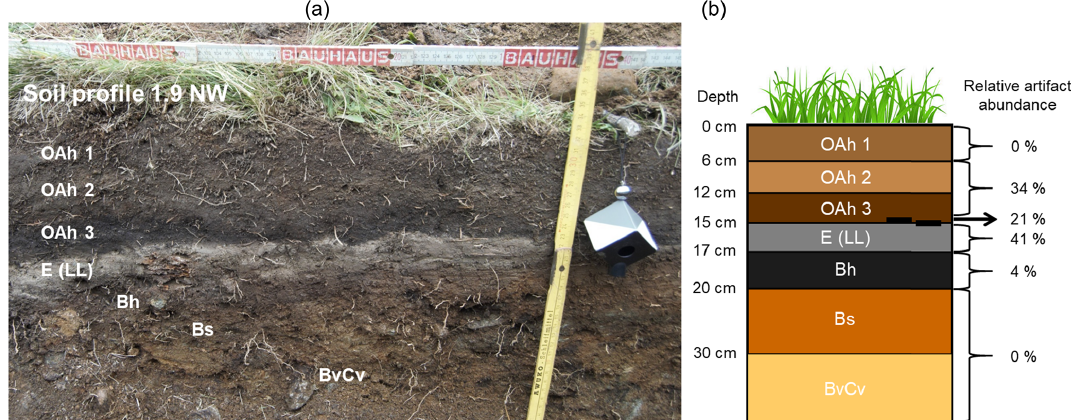
Figure 3. (a) Soil profile 1.9NW, which represents a typical soil profile of the Ullafelsen in the Fotsch Valley, Stubai Alps, Austria. (b) Schematic horizons of the soil profiles on the Ullafelsen. Note that the soil profiles reveal a high heterogeneity. Nevertheless, the soil hori- zons OAh3 and Bh are characterized by a humus enrichment. The E (LL) horizon (light layer) reveals the highest relative artifact abundance ( ∼ 41%) and is overlain by several fireplaces on the Ullafelsen. This horizon is considered the living floor of the Mesolithic hunter-gatherers (Geitner et al., 2011, 2014). Due to TOC content partly ≥ 15%, we adopted the soil horizon classification by Zech et al.